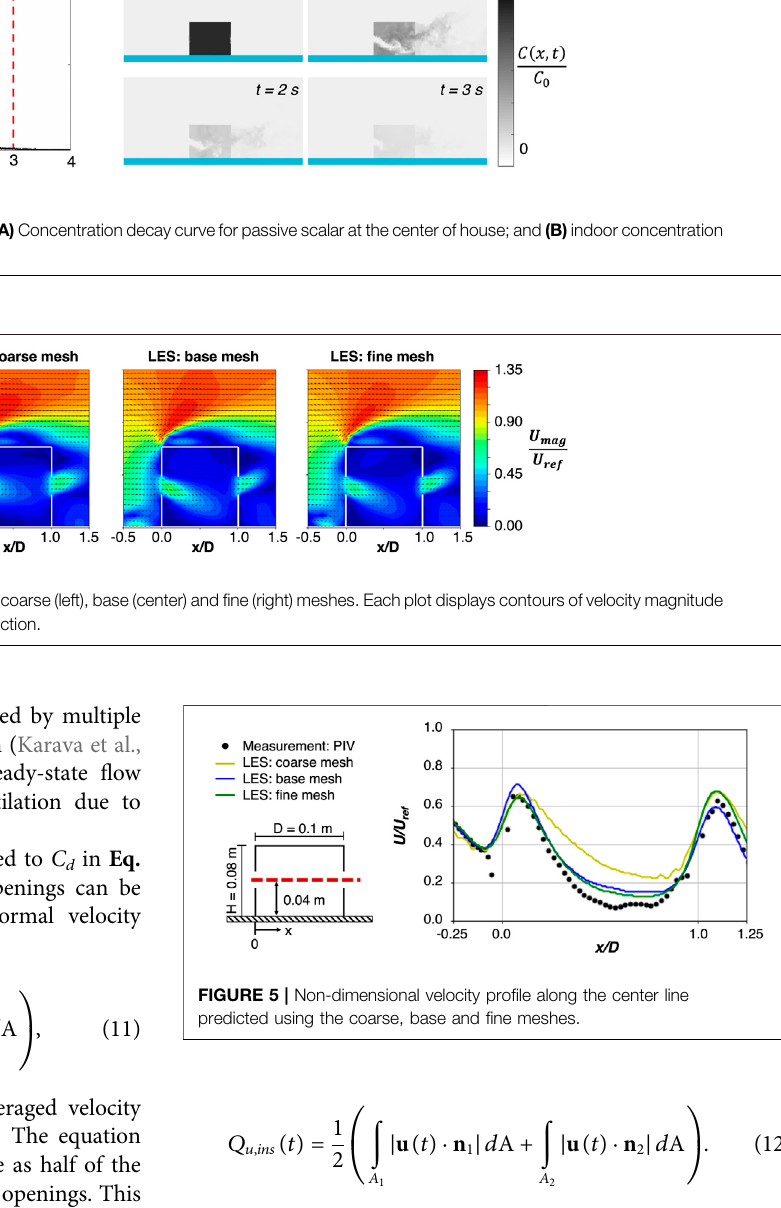
Frontiers in Built Environment |